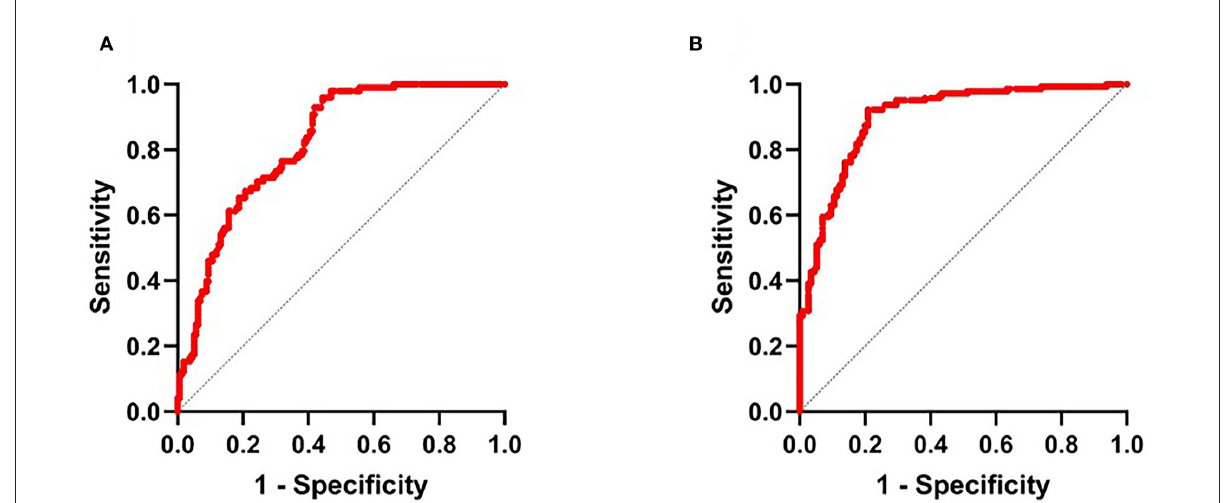
FIGURE2 (A) Receiver operator characteristic (ROC) curve for NLR2 in the auxiliary diagnosis of HT and (B) ROC curve for NLR2 in the auxiliary diagnosis of unfavorable outcome. NLR2, neutrophil-to-lymphocyte ratio after thrombectomy immediately.